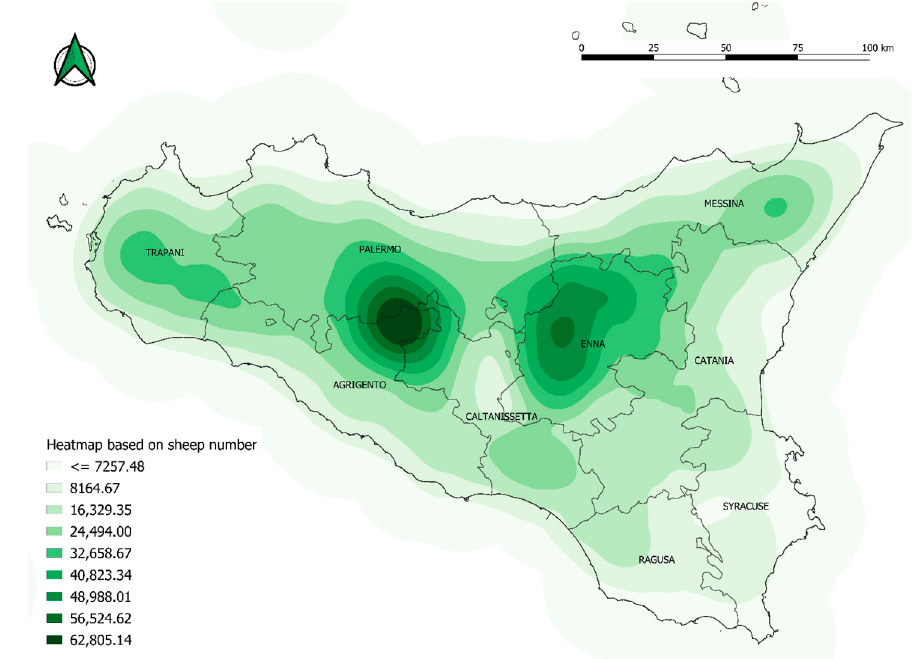
Figure 7. Heatmap based on the distribution of sheep farms at provincial level.